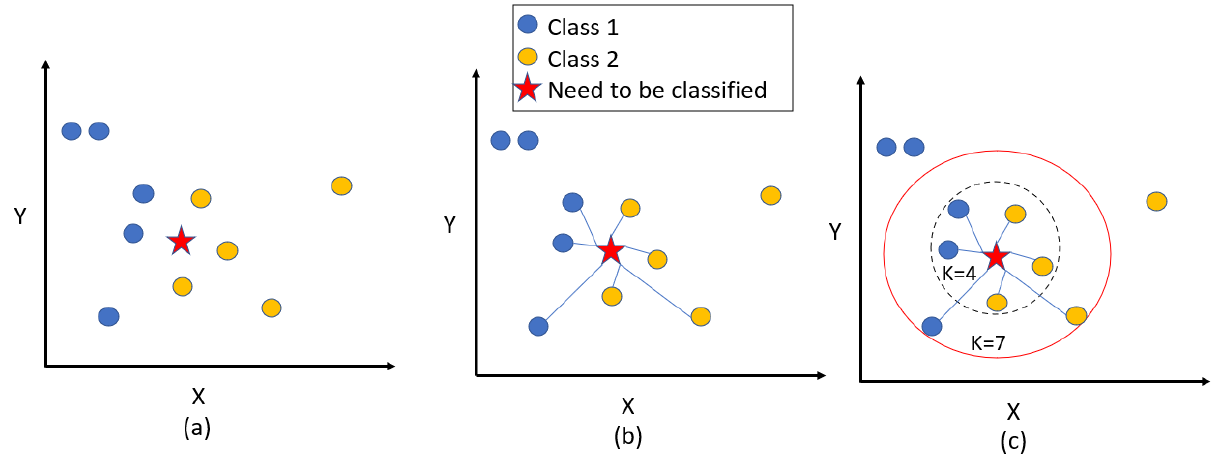
Figure 7. KNN Classifier. ( a ) shows the initial stage of the KNN algorithm. ( b ) shows the calculation stage for computing the distance between neighbors. ( c ) shows the classification stage based on the K value.